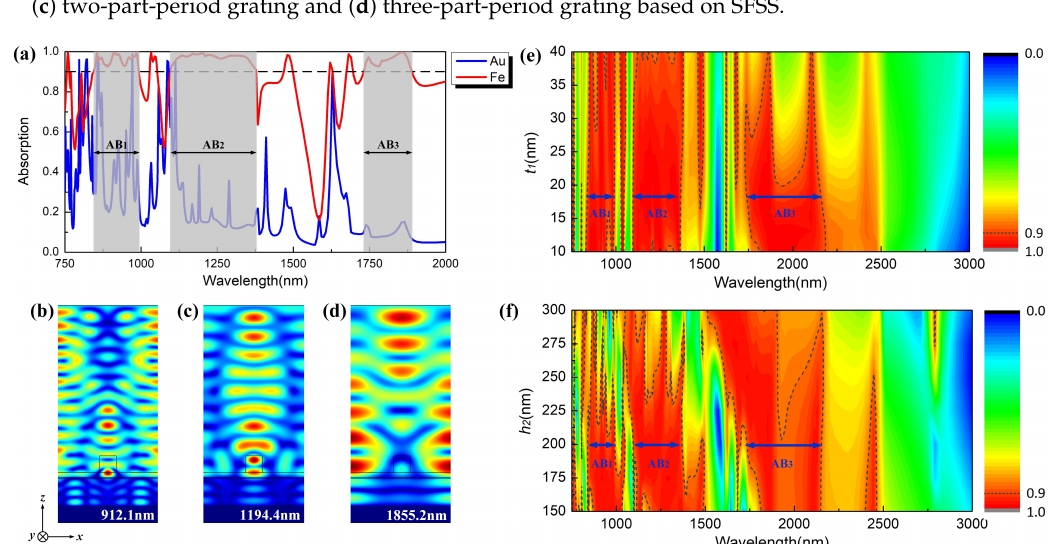
Figure 2. ( a ) absorption spectrum of the ordinary grating supported by SGSS and SFSS; Electric field of the proposed structure in the vertical direction at the wavelength of ( b ) 912.1 nm; ( c ) 1194.4 nm and ( d ) 1855.2 nm, respectively; absorption spectra of the single-layer GSFS varying with ( e ) thickness t 1 of Fe layer and ( f ) thickness h 2 of the upper SiO 2